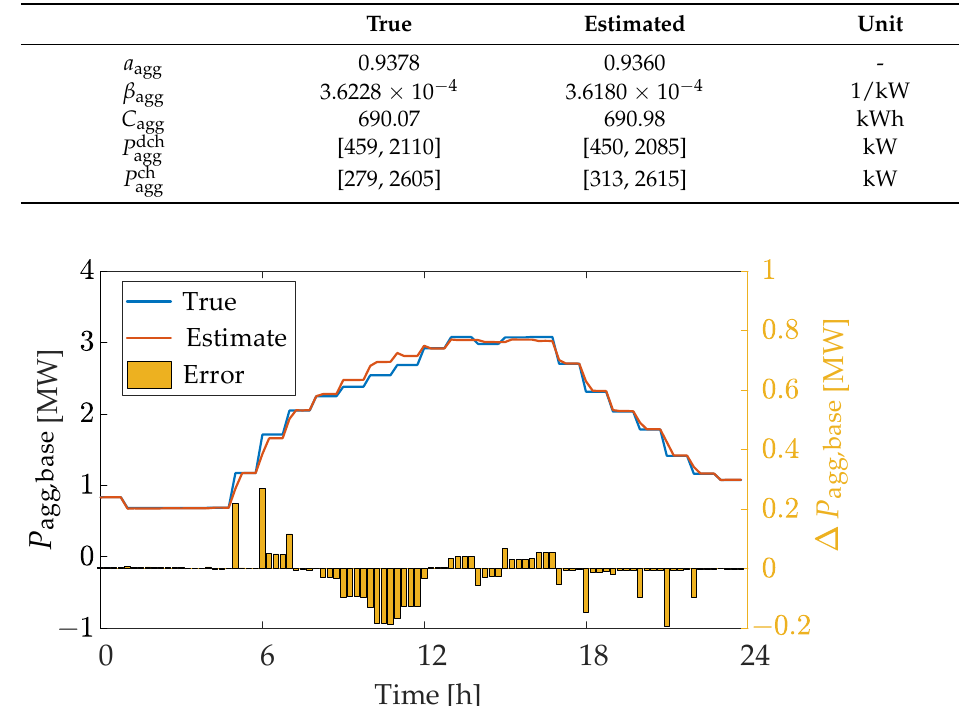
Figure 6. Estimated and true values of the aggregate baseline power; and the difference between them.